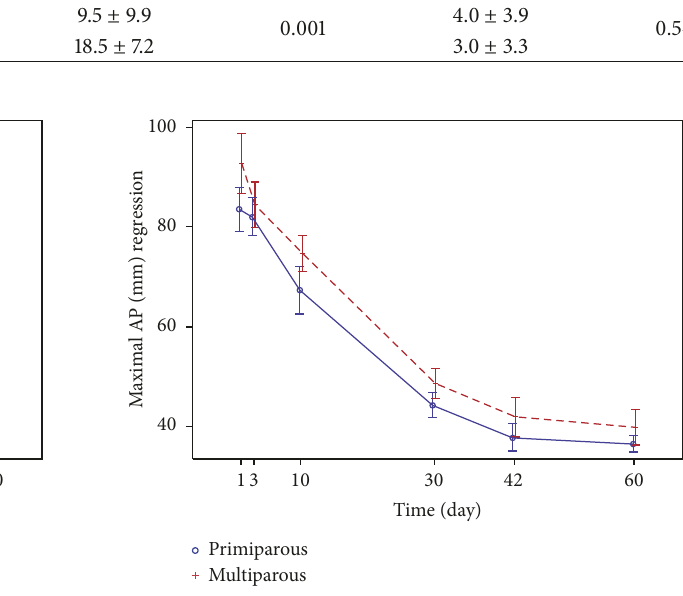
Figure 9: Maximal AP (mm) regression.